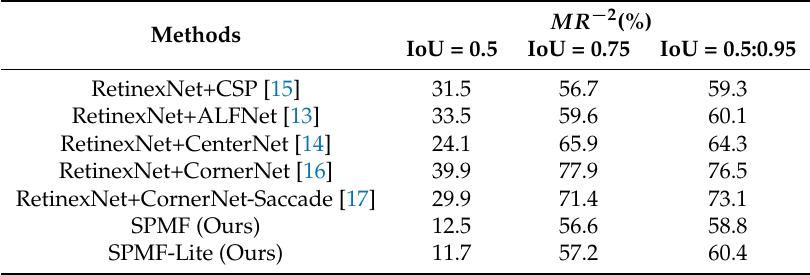
Figure 7. Visual results (cascade testing mode) from the different detection methods. Five images from the low-light CityPersons testing set is selected as the samples to show the detected results. Table 4. Comparison with the state of the arts on low-light CityPersons (Cascade testing